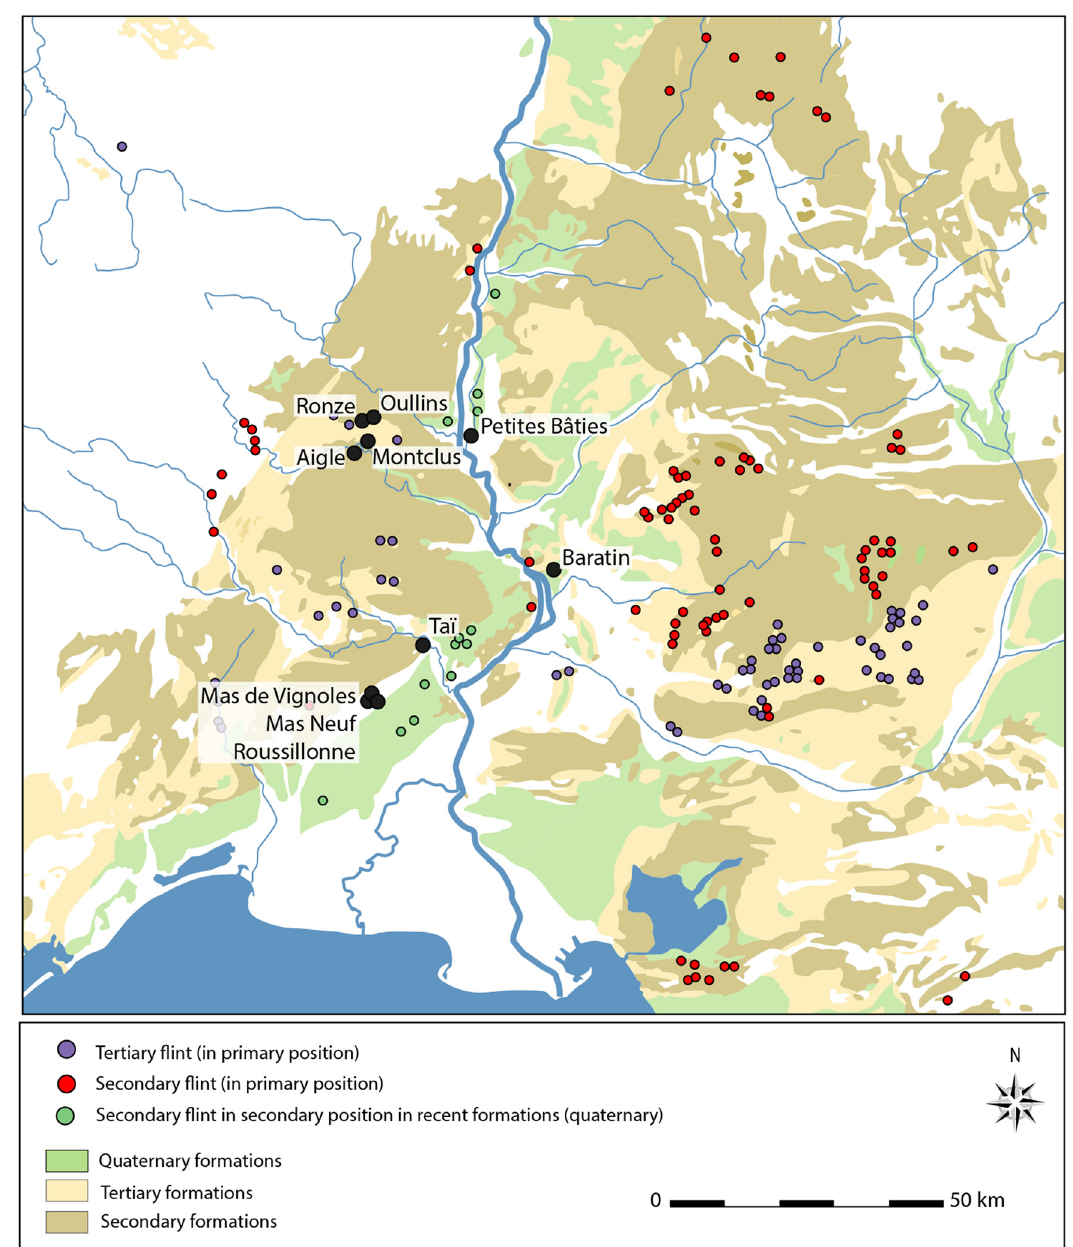
Figure 3: Map showing the provenance of the di ff erent siliceous raw materials, after Perrin, 2014, modi fi